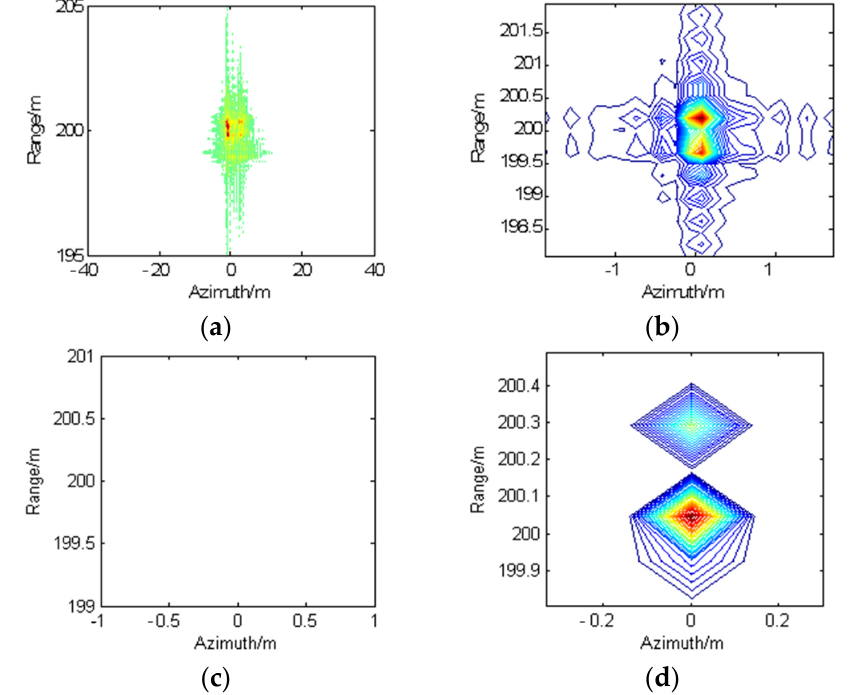
Figure 6. Point targets imaging results, ( a ) CSA with PGA applied; ( b ) CSA with proposed one- step MOCO method; ( c ) imaging method in [20]; ( d ): proposed imaging method. MOCO method; ( c ) imaging method in [20]; ( d ): proposed imaging